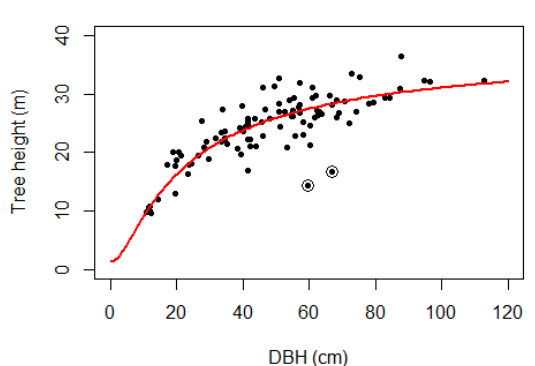
Figure 2. Diameter-Height relationship for the sample trees used for deriving form factor. Two circles indicate outliers not used for fitting the Diameter-Height function.